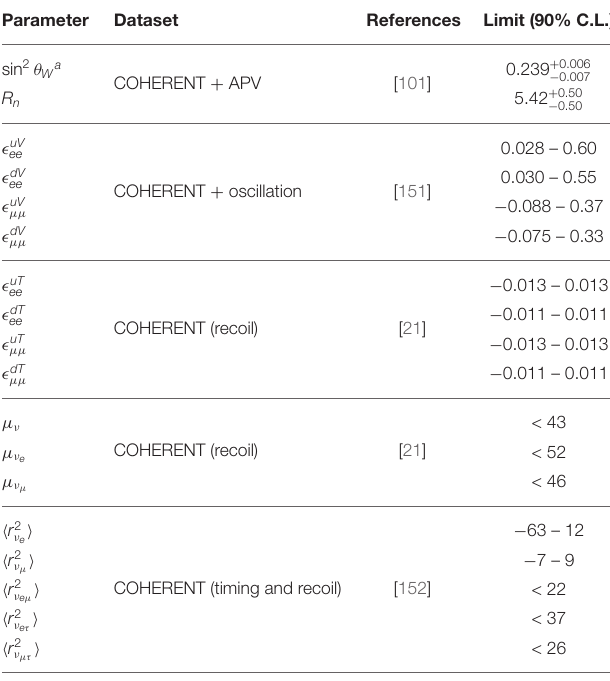
TABLE 2 | Constraints on electroweak, nuclear and new physics parameters at 90% C.L. after the first CE ν NS measurement by the COHERENT experiment. Parameter